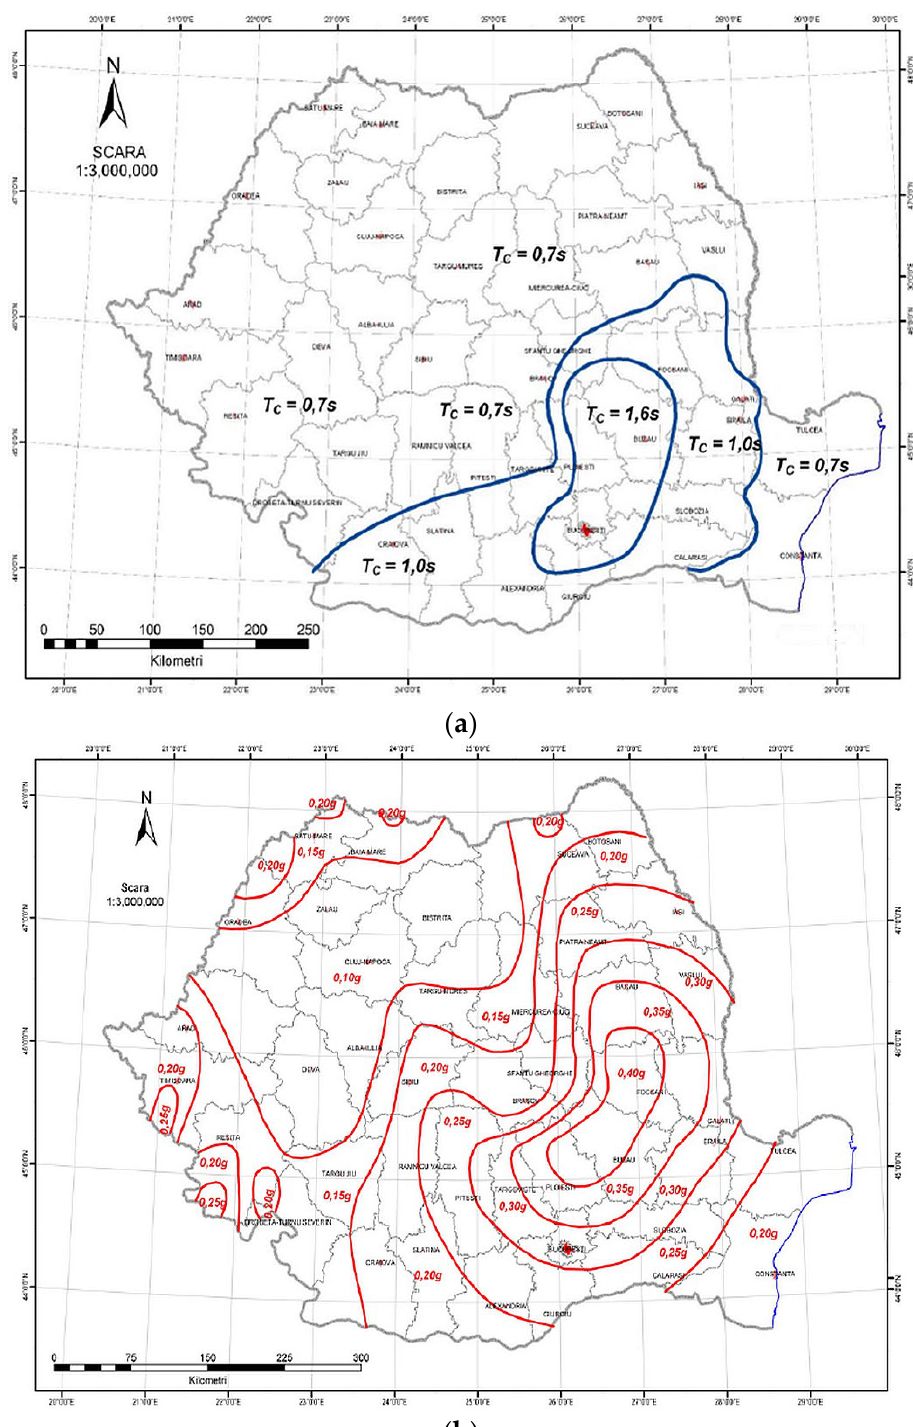
Figure 3. Seismic area information for Romania [18]: ( a ) corner period values, Tc distribution; ( b ) design ground acceleration values for earthquakes with return period of 225 years.